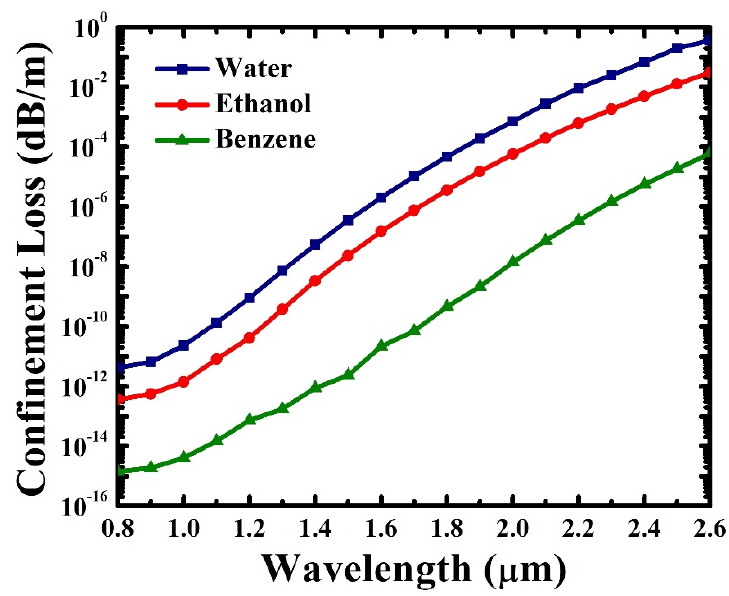
Figure 7. Confinement loss of the PCF sensor with respect to wavelength for water, ethanol and benzene.